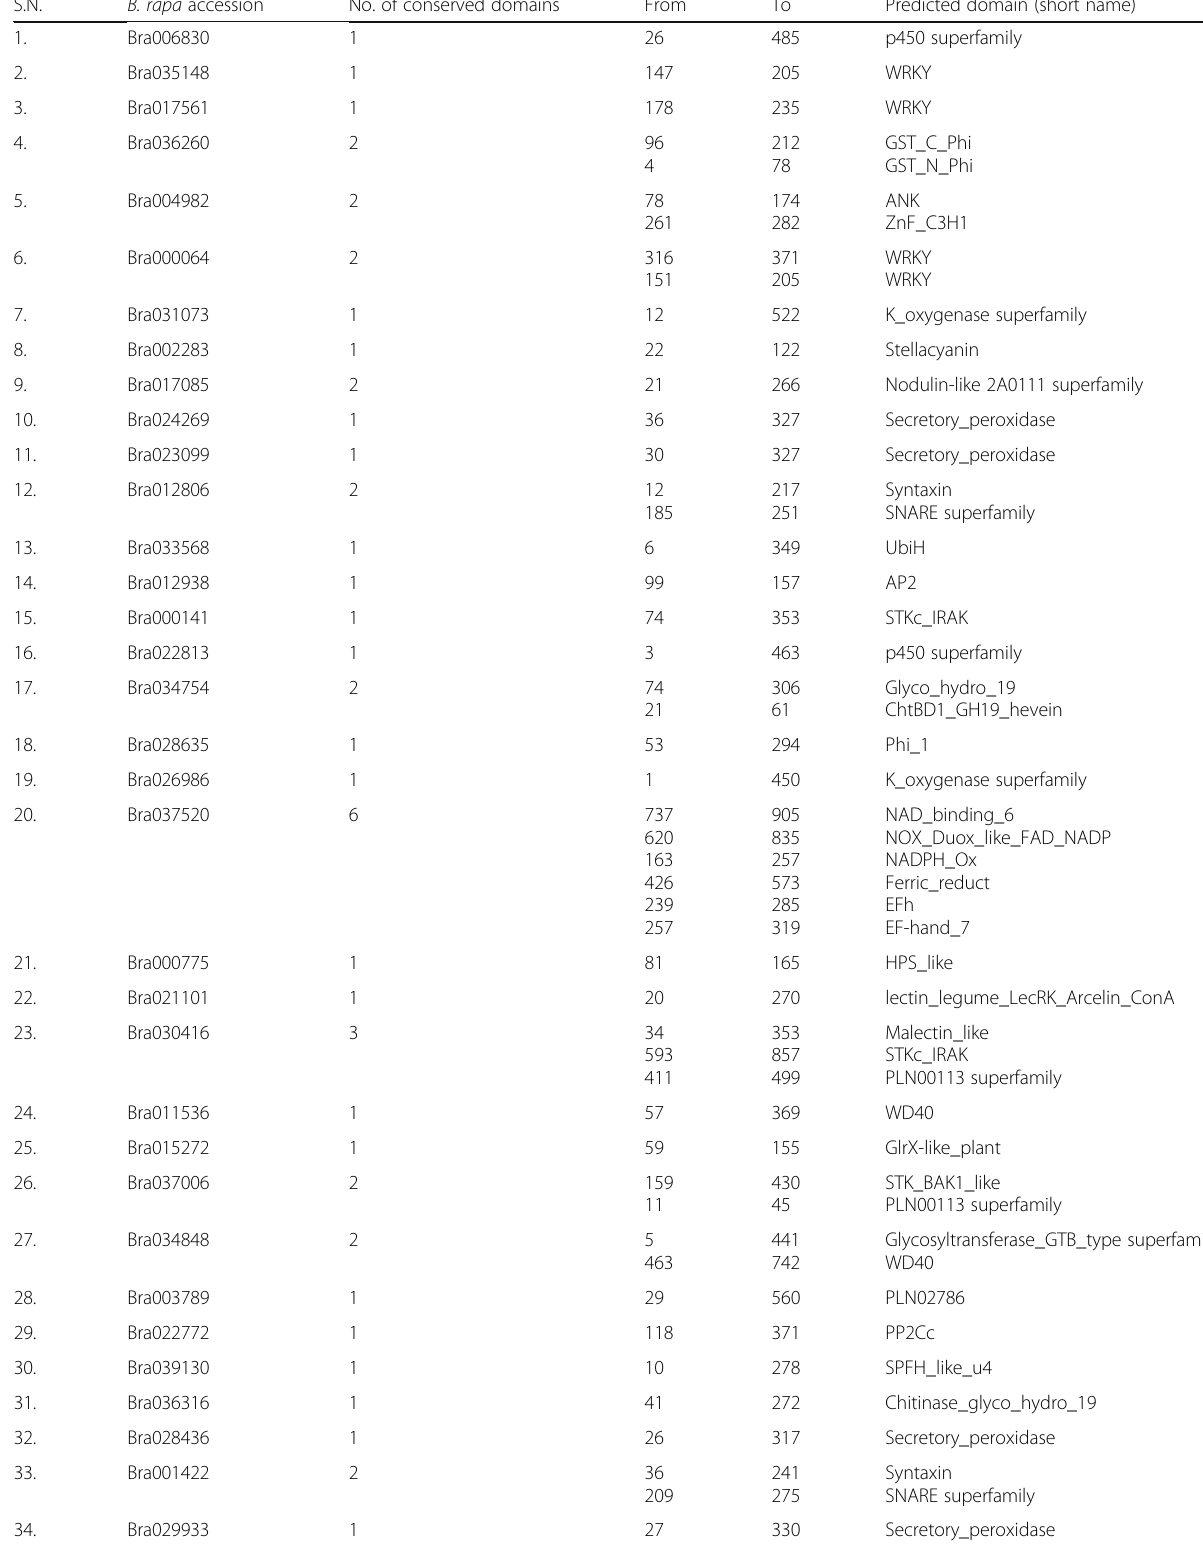
Table 2 Predicted conserved domains in identified upregulated Brassica rapa sequences with their positions under contrast WTC